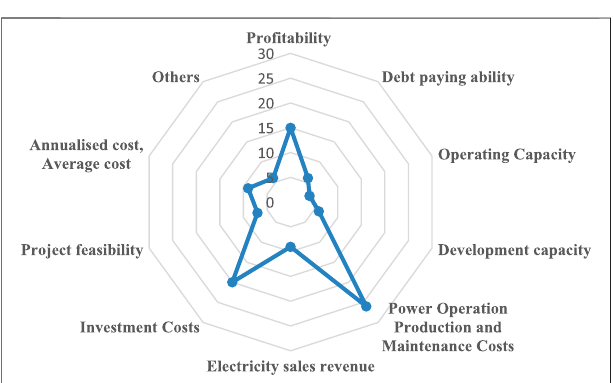
FIGURE 8 | Classi fi cation and frequency of economic sustainability indicators.